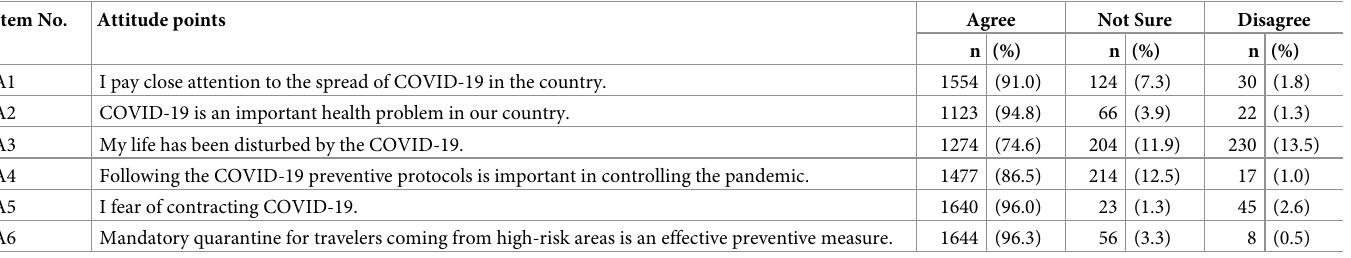
Table 4. Attitudes towards COVID-19 preventive measures among participants surveyed for the knowledge, attitude and practices survey in Bhutan, January–Feb- ruary, 2022 (n = 1708). Item No.